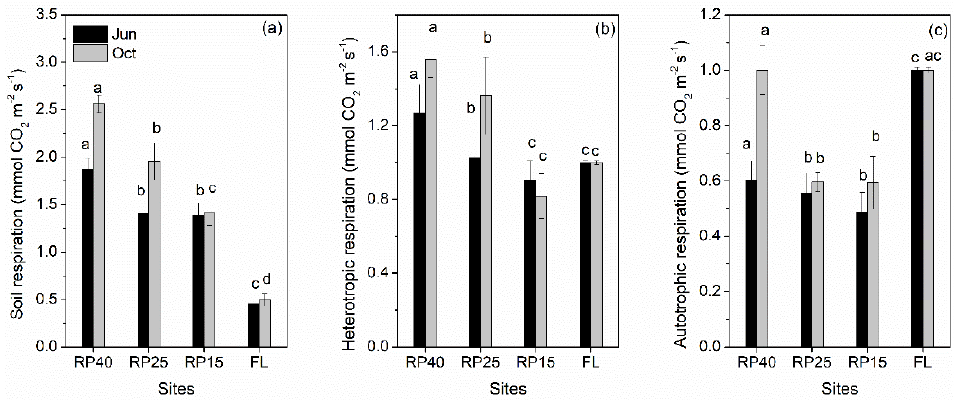
Figure 3. Soil respiration ( a ) and its components (( b ) soil heterotrophic respiration, ( c ) soil autotrophic respiration) after afforestation. Different letters denote significant ( p < 0.05) differences among sites in same month; error bar represents standard error. Note: 40, 25, and 15 years of Robinia pseudoacacia L. indicated as RP40, RP25, and RP15.